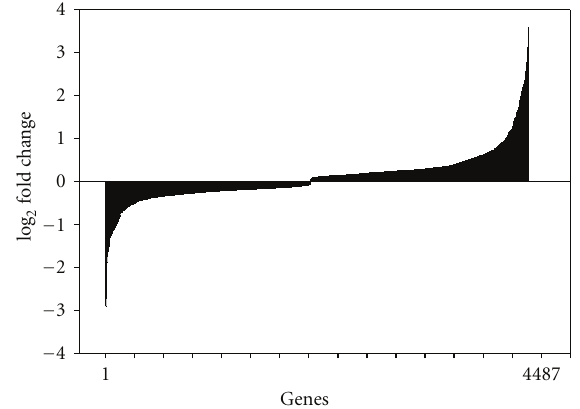
Figure 4: The log expression ratio of the E . coli O157:H7 genome was plotted for Luria broth versus sterile soil. Genes more highly expressed in LB have a negative value, whereas genes more highly expressed in soil have a positive